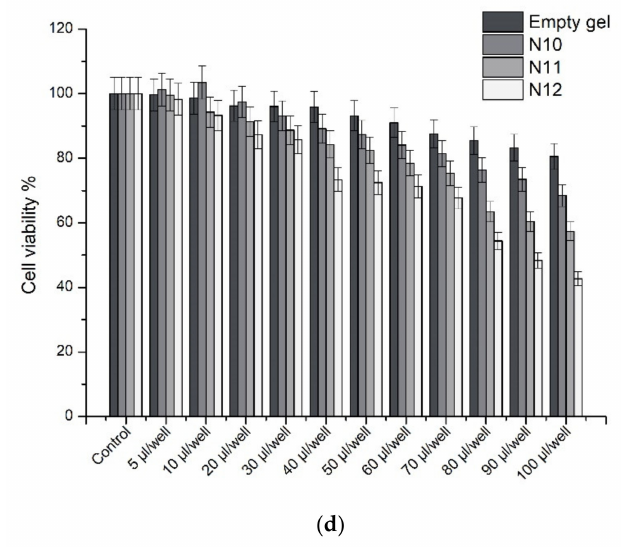
Figure 5. The cell viability results of all in situ formulations on the SIRC cell culture line after 24 h. ( a ) gel with 0.5% RJ, ( b ) gel with 0.75% RJ, ( c ) gel with 1% RJ, and ( d ) N10, N11, N12. An empty gel formulation was used in order to evaluate the impact of the excipients for the cell viability. Data represent mean standard deviation (SD), n =